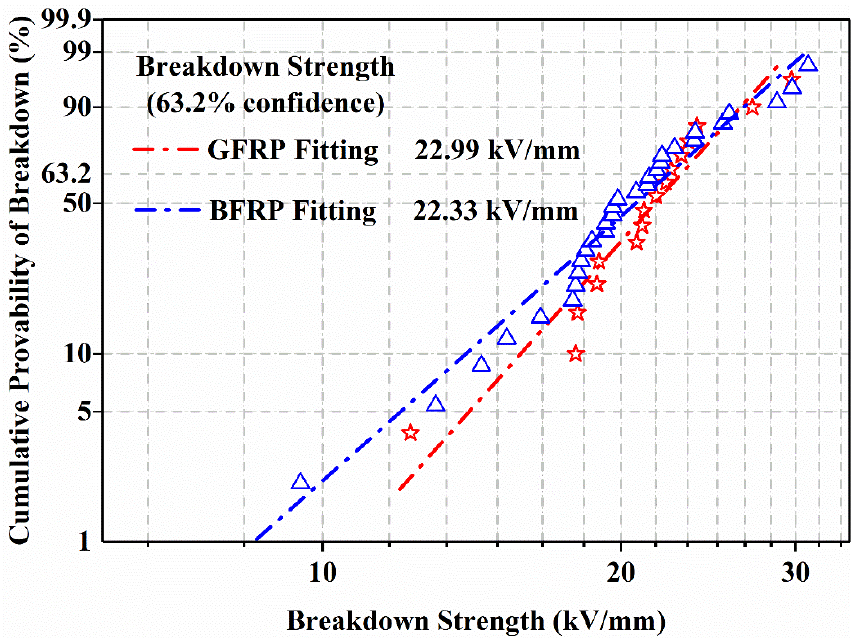
Figure 11. Weibull distribution of the breakdown strength.